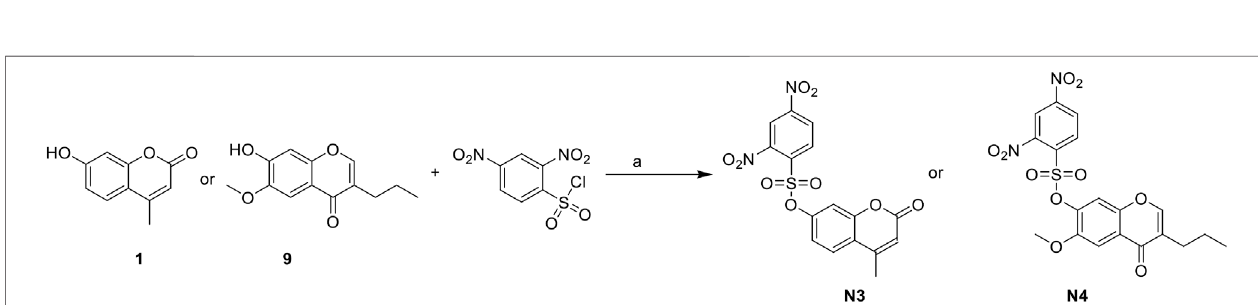
SCHEME 4 | The synthetic routes of N3 and N4. Reagent and conditions: (a) DIPEA, dry DCM, RT, Yield: 45.6% (N3) and 55.2% (N4).